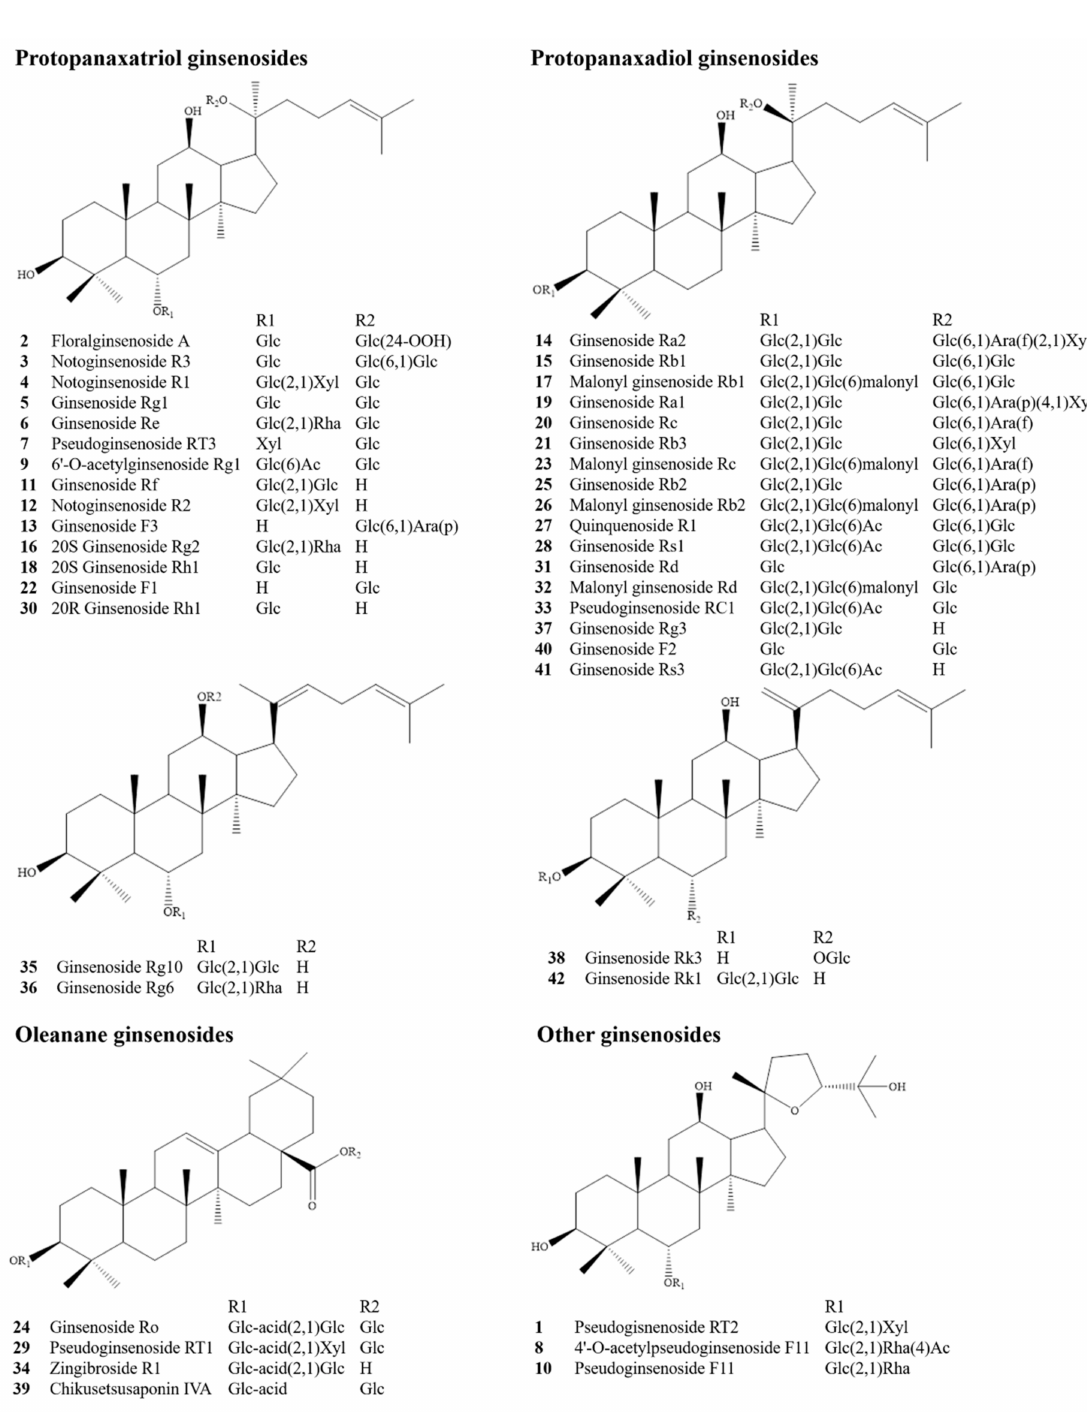
Figure 1. Chemical structures of the 42